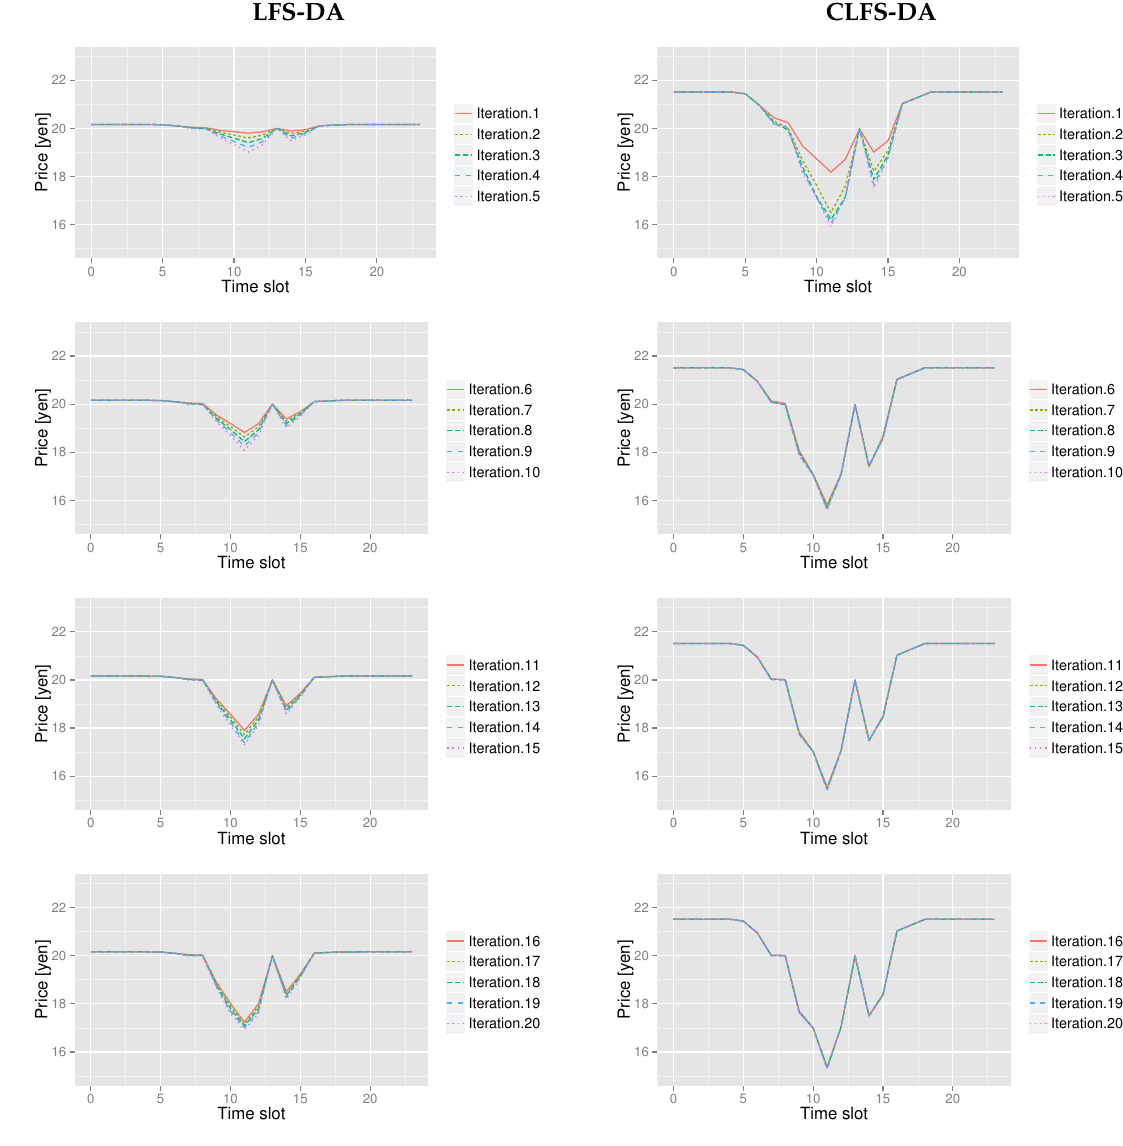
Figure 5. Price profiles obtained at each iteration when ( left ) the LFS-DA and ( right ) the CLFS-DA are used,